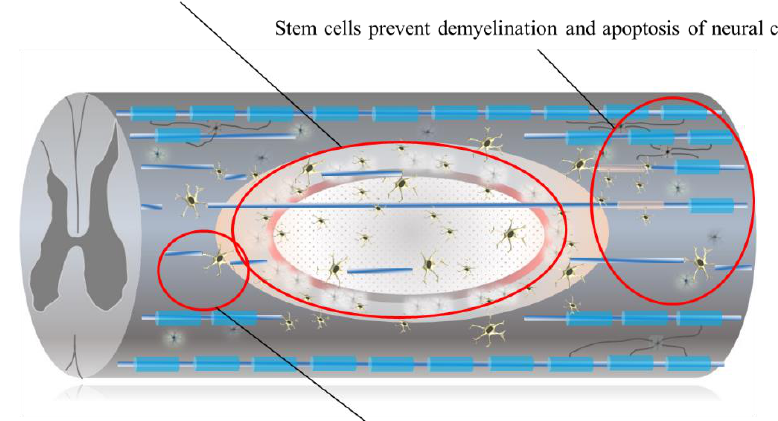
Figure 3. Grafted stem cells can replace the lost neurons, oligodendrocyte, and astrocytes. They prevent demyelination and apoptosis of neural cells they can modulate the immune response and also promote the blood–spinal cord barrier disruption healing.